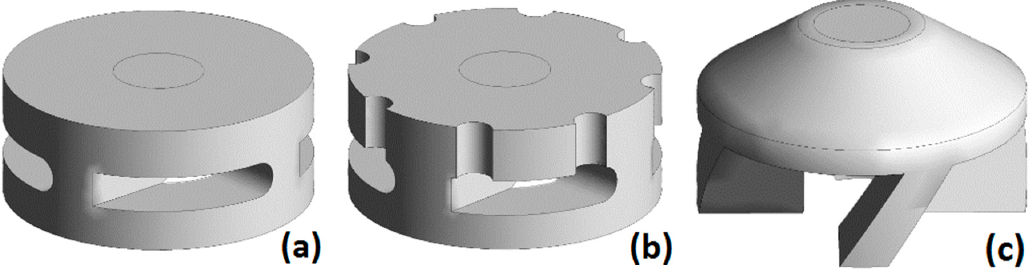
Figure 2. Three impeller designs tested in this research. ( a ) Commercial impeller design A; ( b ) Commercial impeller design B; ( c ) New design proposed in previous work [16] design C.